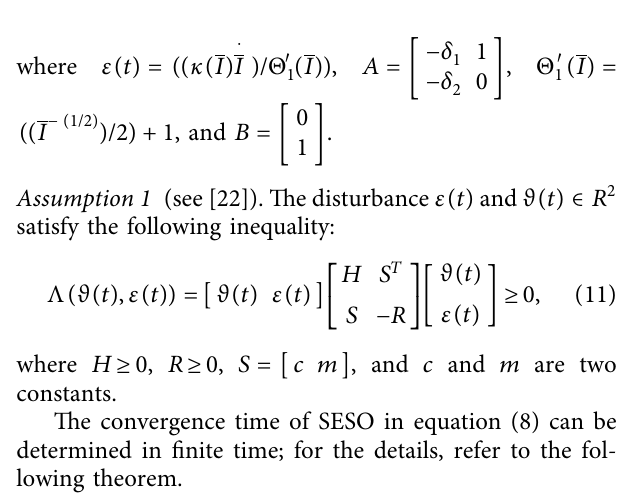
Figure 1: Diagram of a PMSM control